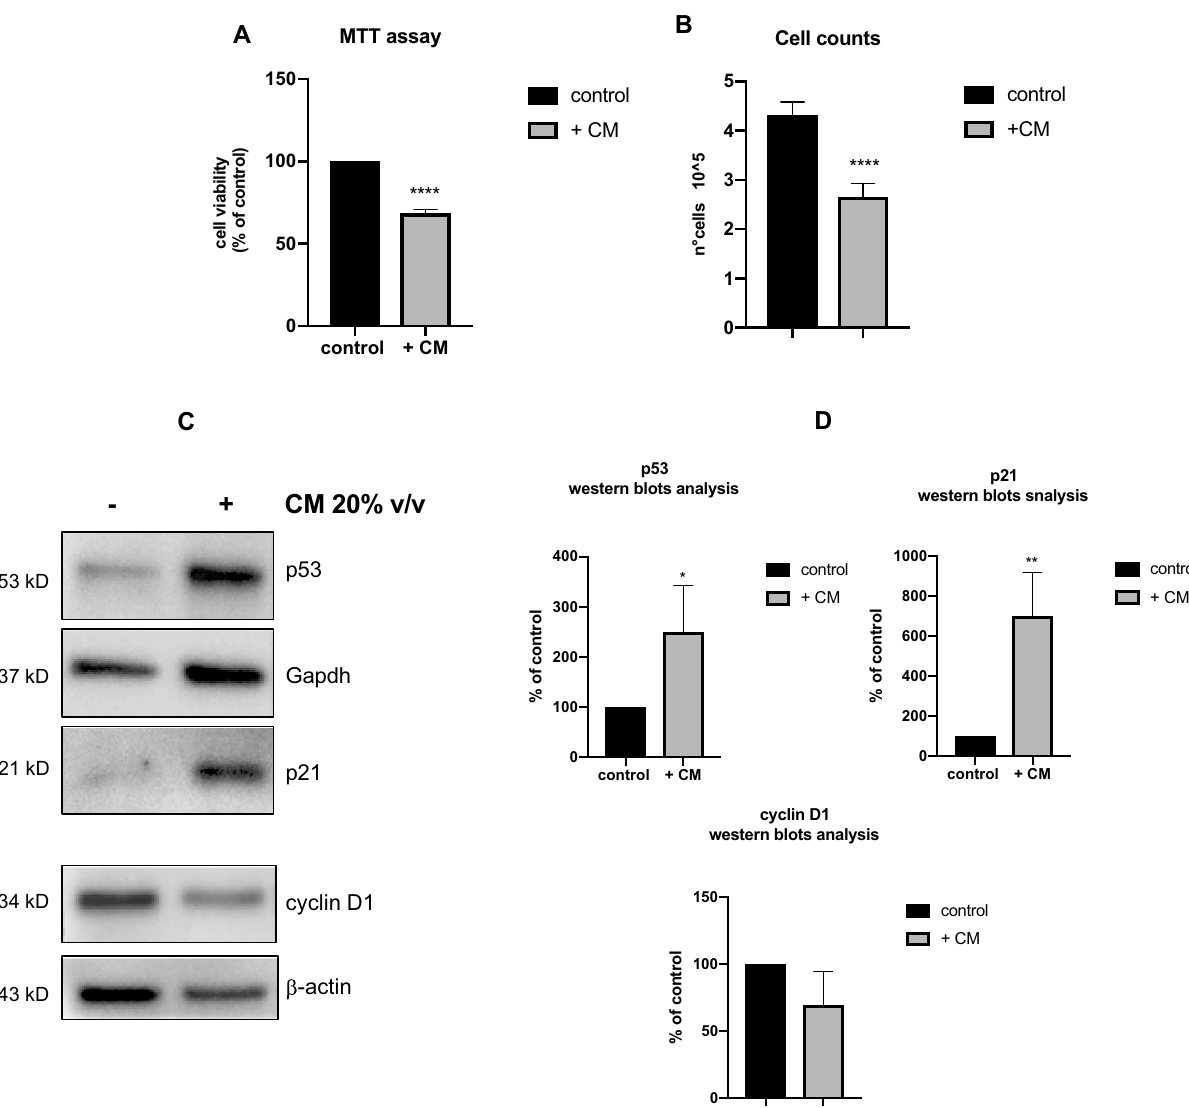
Figure 3. The conditioned Medium of L. gasseri SF1183 reduces proliferation of HCT116 cells. ( A ) Proliferating HCT116 cells were incubated in complete cell culture media supplemented or not with CM (20%v/v) for 16 h; after that, cells were washed out from CM and treated for MTT assay. Statistical analyses were performed using unpaired t-test. Levels of significance between points of expression are indicated (**** p < 0.0001). ( B ) Proliferating HCT116 cells were incubated in complete cell culture media supplemented or not with CM (20%v/v) for 16 h; after that, cells were washed out from CM After 24 h cells were collected and counted. Levels of significance between points of expression are indicated (**** p < 0.0001). ( C ) Proliferating HCT116 cells were incubated for 16 h in complete cell culture media supplemented with CM where indicated; after that, cells were collected, whole cell extracts were prepared and analyzed by western blot with antibodies against p53, p21, cyclinD1, b-actin and Gapdh. ( D ) Quantification of normalized protein levels from three independent replicates performed by ImageLab Statistical analyses were performed using unpaired t-test. Levels of significance between points of expression are indicated (* p = 0.00482; ** p =